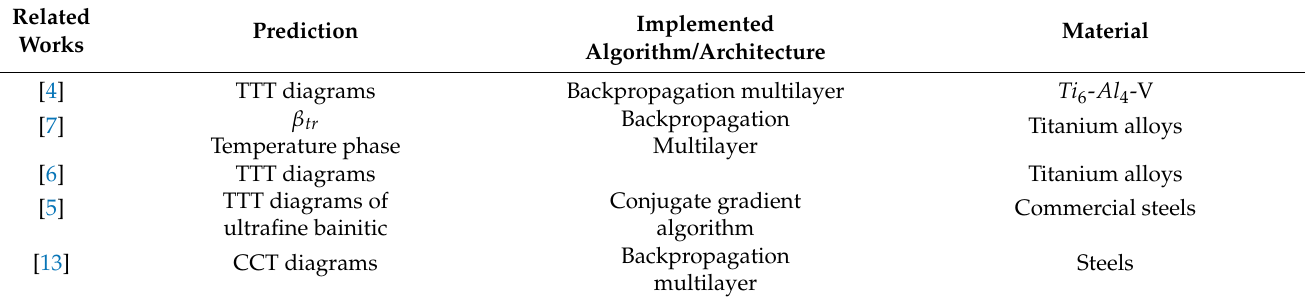
Table 1. Related works for TTT prediction. Due to the novelty of the use of ML techniques in the prediction of TTT diagrams, there are still few reported